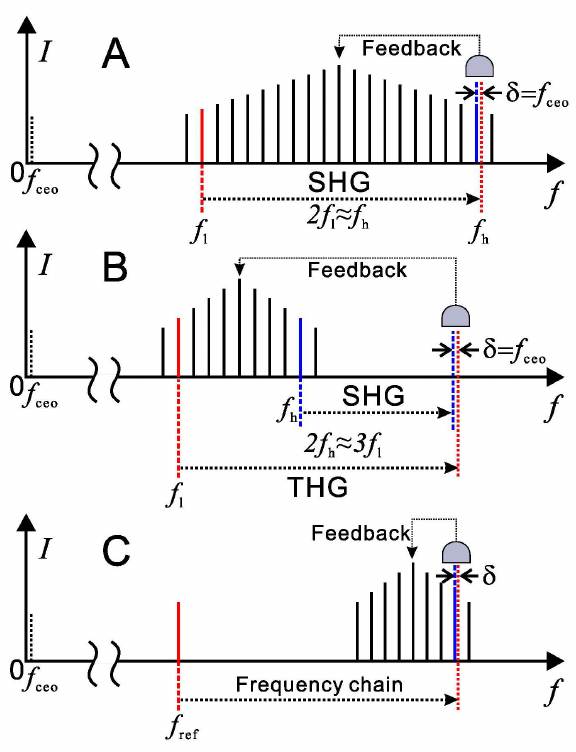
Figure 1: Self-referencing carrier envelope phase stabilization with (A) f -2 f and (B) 2 f -3 f mismatch detection techniques and (C) ex- ternal referencing carrier envelope phase stabilization to lock the comb spectrum to a known frequency f ref via the bridging of a fre- quency